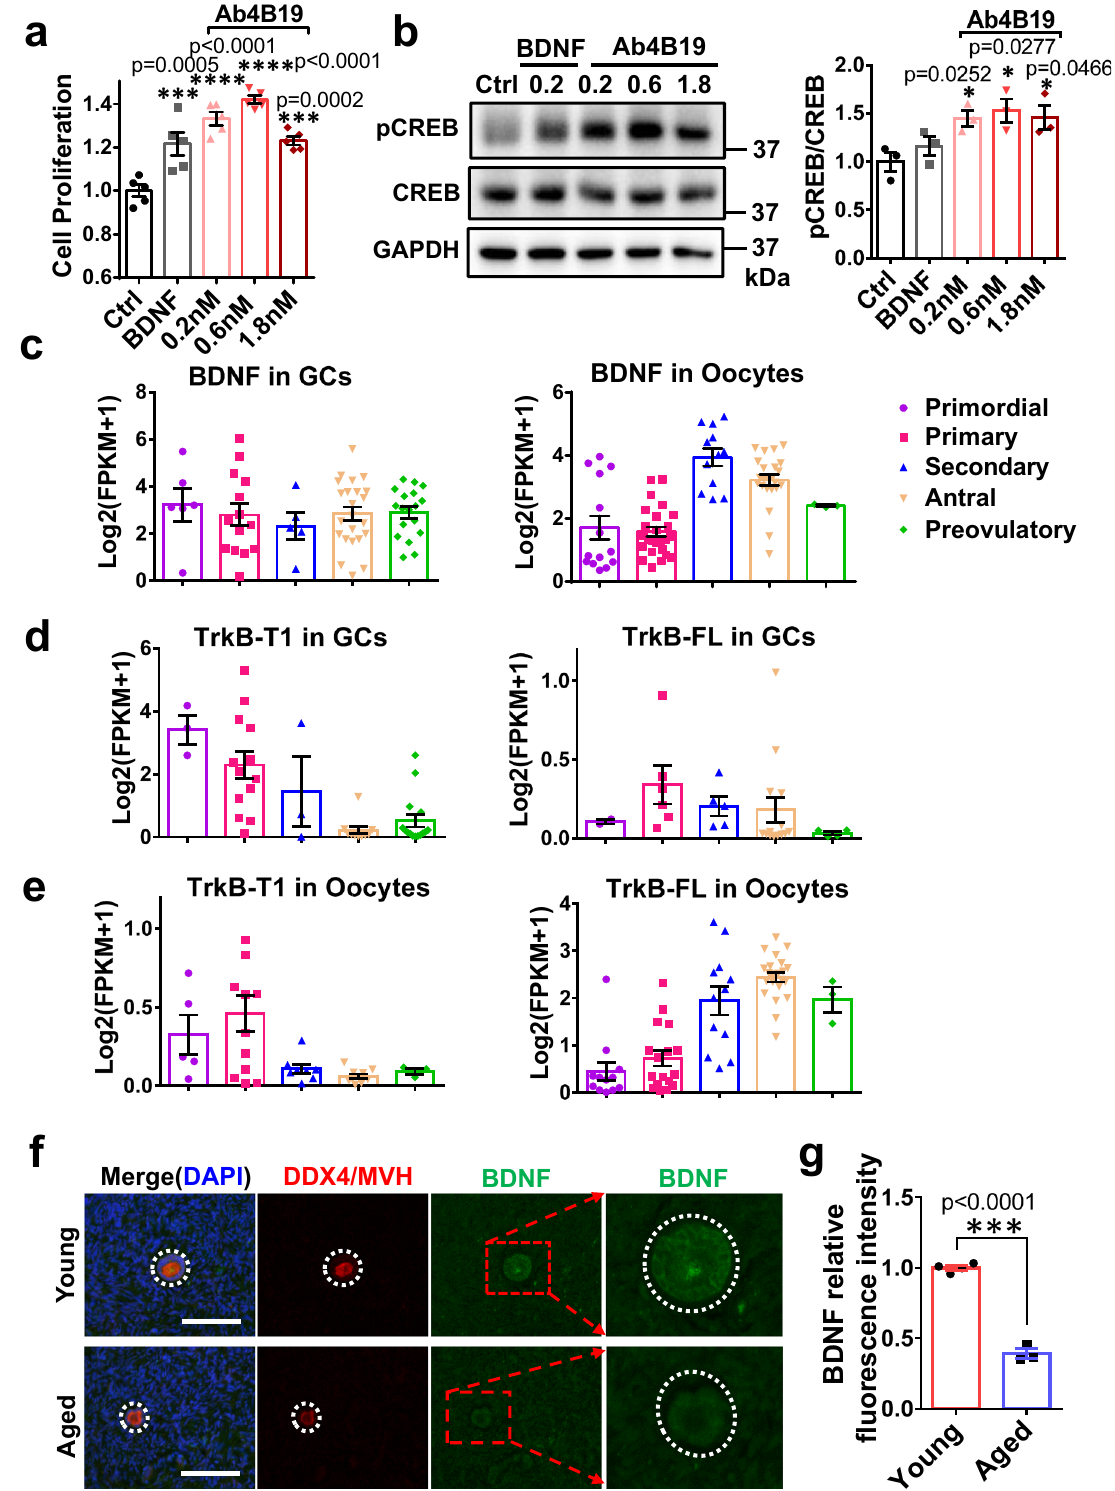
repair mechanism mediated by the BDNF-TrkB signaling path- way. Second, Ab4B19 reverses infertility by preserving folliculo- genesis in two animal models of POF. Third, Ab4B19 also exhibits excellent drug-like properties, overcoming the short- coming of BDNF. Finally, Ab4B19 did not induce any visible side effects in mice. Therefore, Ab4B19 has demonstrated its potential to be a candidate